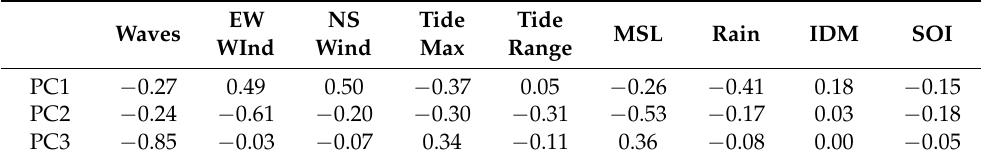
Table 3. Loadings from principal component analysis of metocean drivers of turbidity in the Exmouth Gulf.